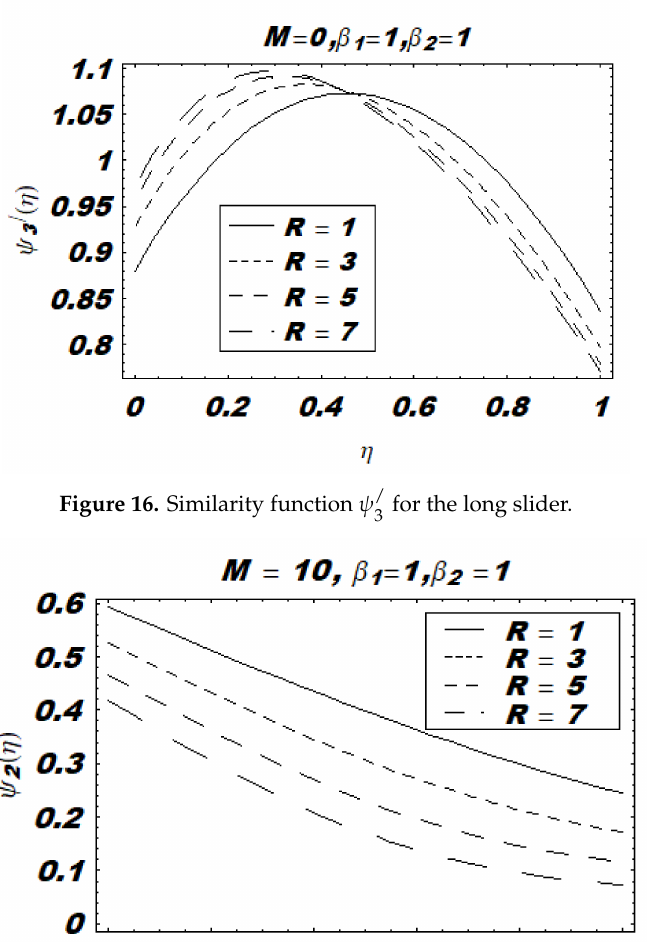
Figure 17. Similarity function ψ 1 for the long slider.